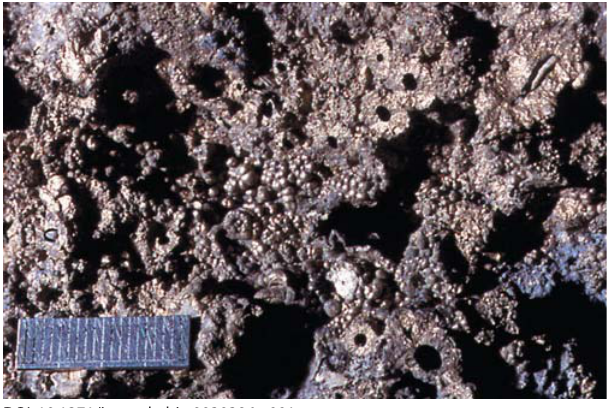
Figure 1. Tynagh